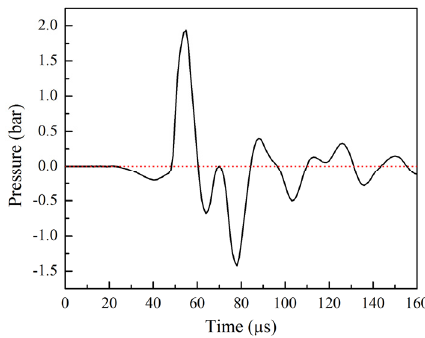
Figure 5. Pressure ‐ time history calculated for dispenser outlet.